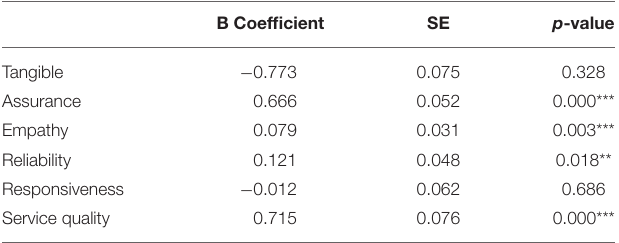
TABLE 4 | Relationship between AE service quality factors and